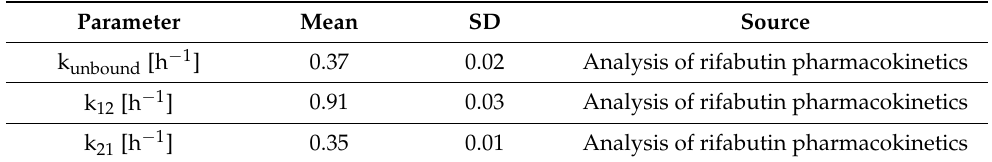
Table 5. Initial estimates for the compartmental analysis of the plasma pharmacokinetics of HSA- stabilized rifabutin nanoparticles and rifabutin-loaded PLGA nanoparticles. The analysis was con- ducted with fixed parameters and SD settings as indicated